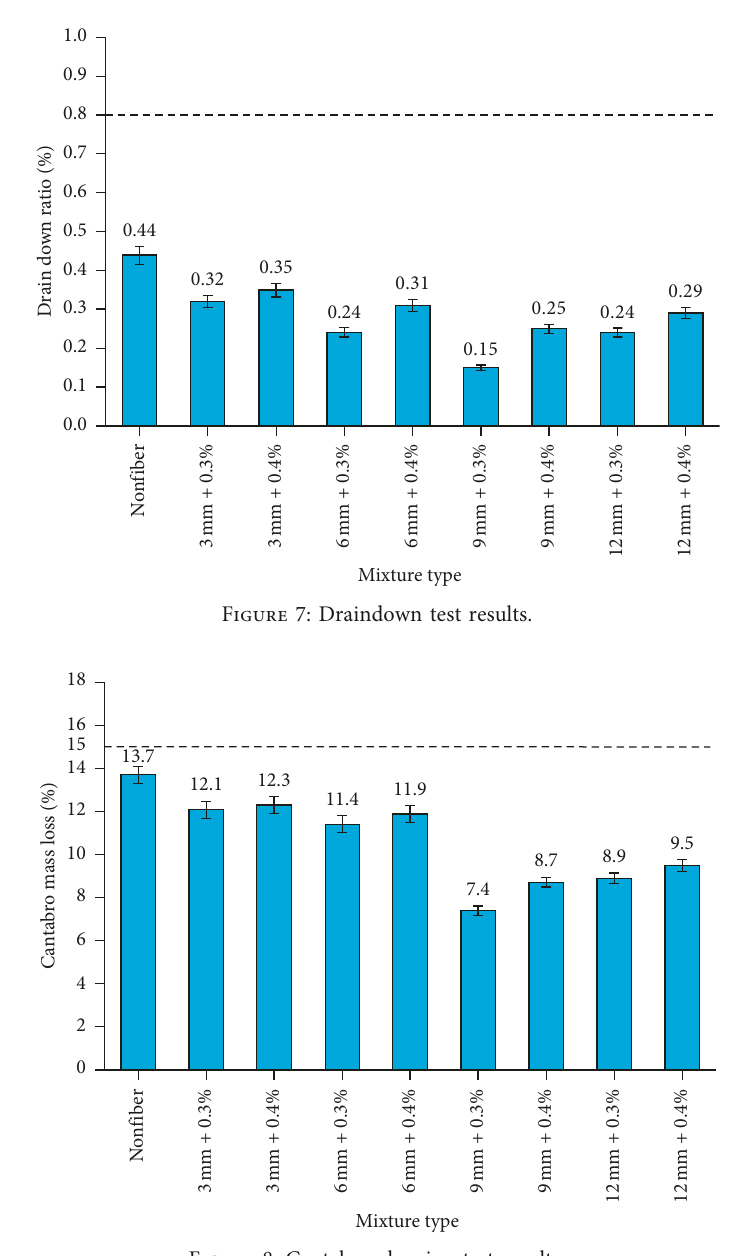
Figure 8: Cantabro abrasion test